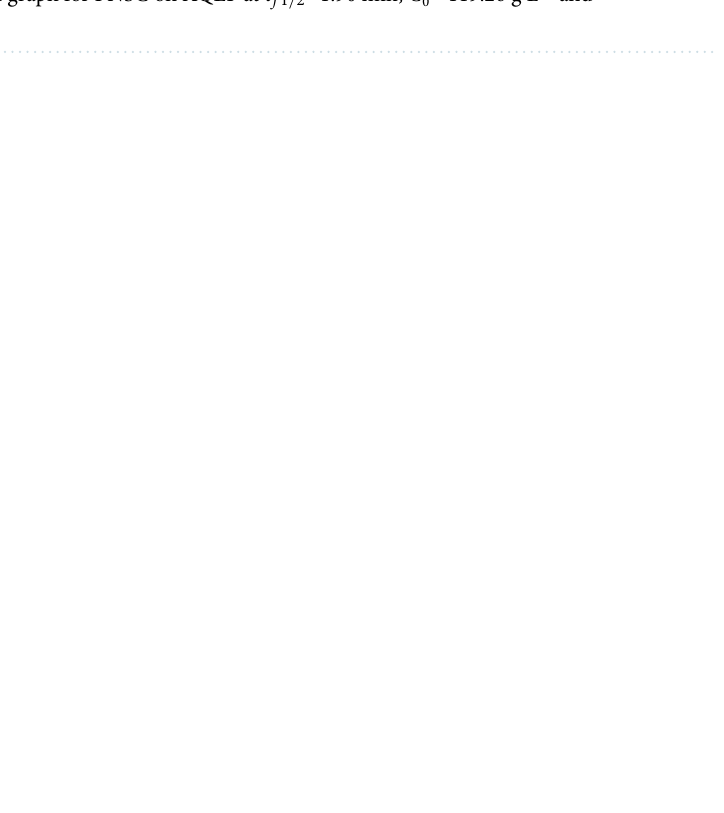
Table 5. PNSC-driven adsorption kinetic parameters for COLR removal on AQEF optimum